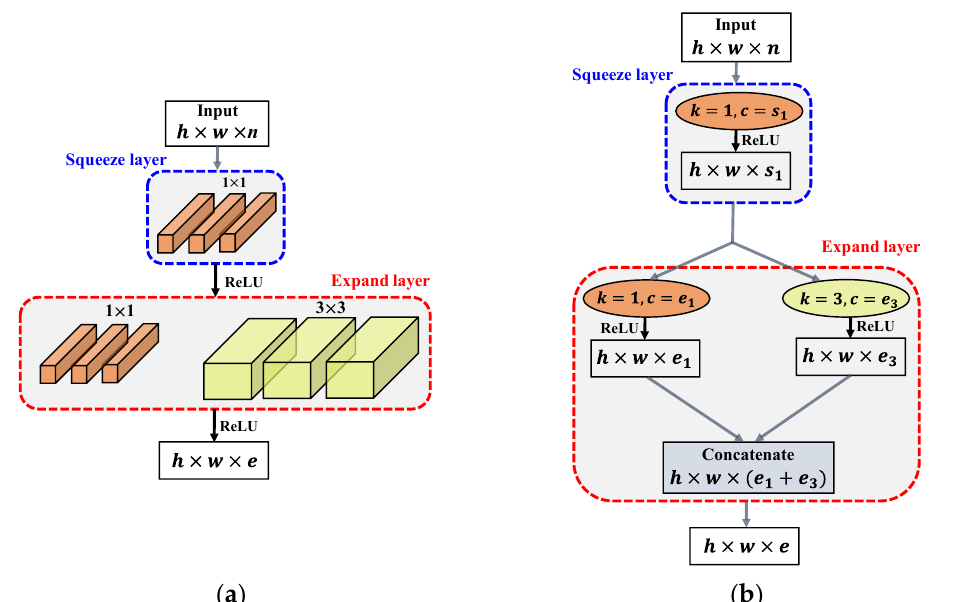
Figure 1. Schematic representation of the fire module. ( a ) Fire module structure and ( b ) workflow of the fire module.